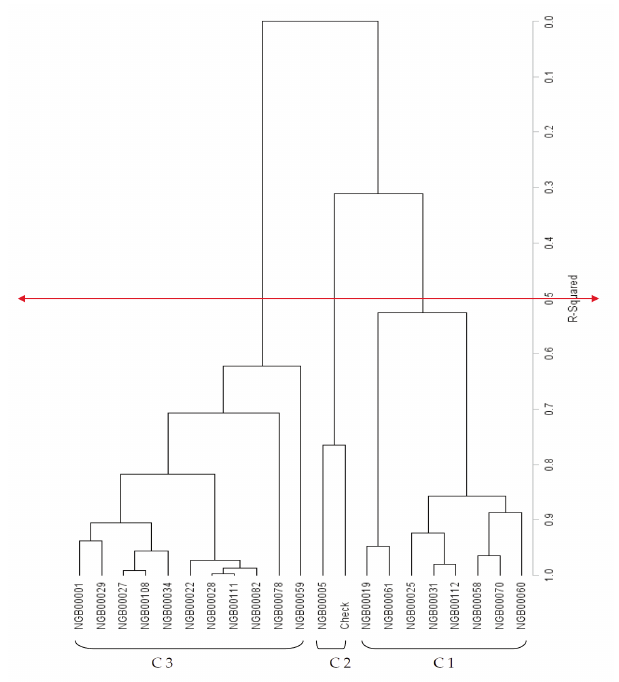
Fig. 3 ­ Dendrogram of relatedness among Amaranthus acces­ sions, (X­axis) based on genetic dissimilarity (Y­axis) from Single­Linkage Cluster analysis. The red double­arrowed line delineates the accessions into clusters at approxima­ tely 0.50 level of dissimilarity; C1, C2, C3 are clusters 1, 2, and 3, respectively.